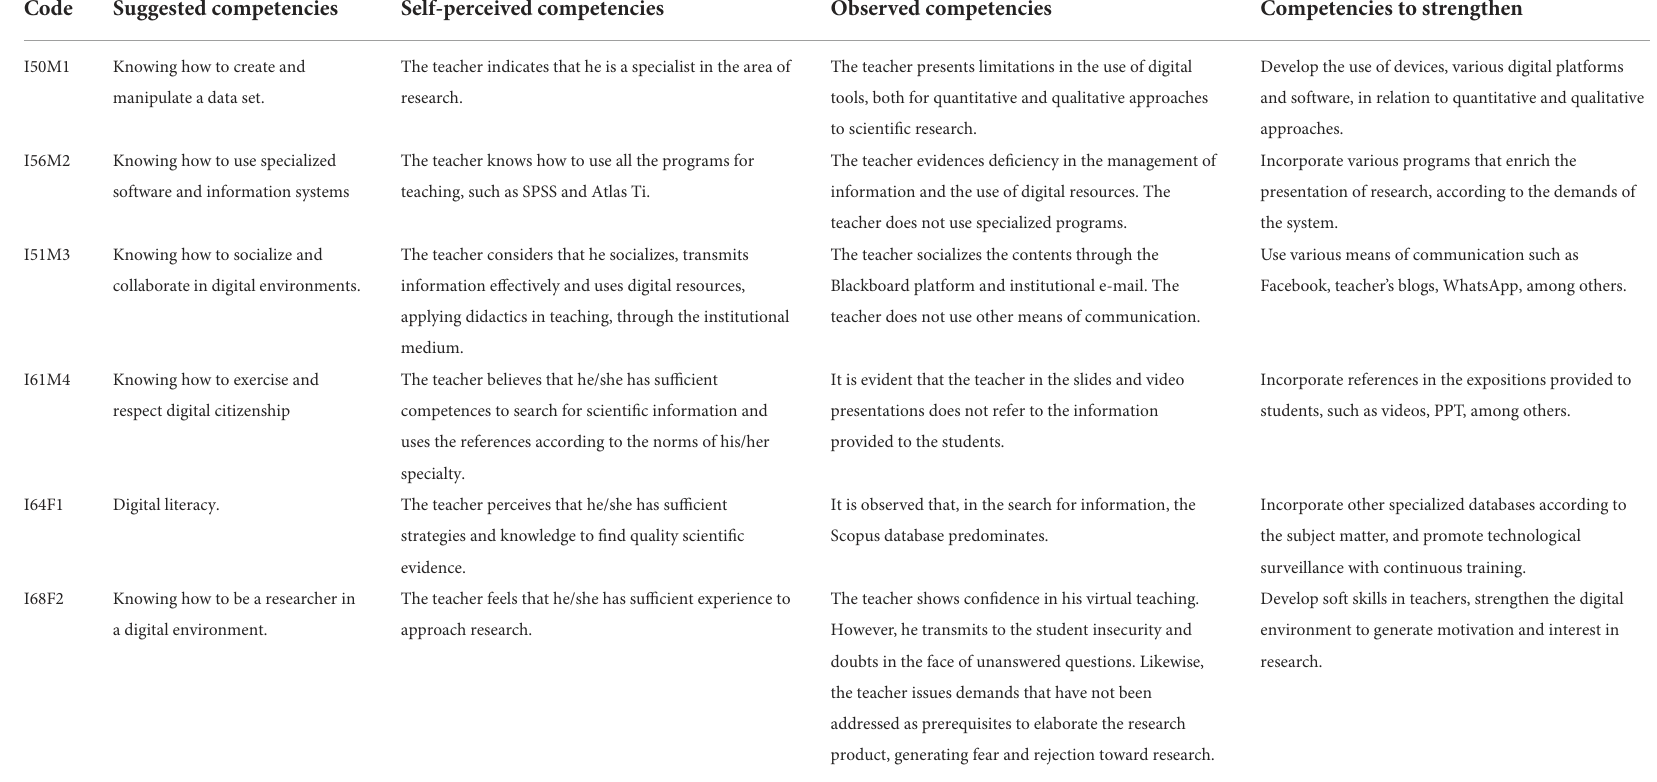
TABLE 8 Analysis of the contrast of the findings of the key participants by competencies. Code Suggested